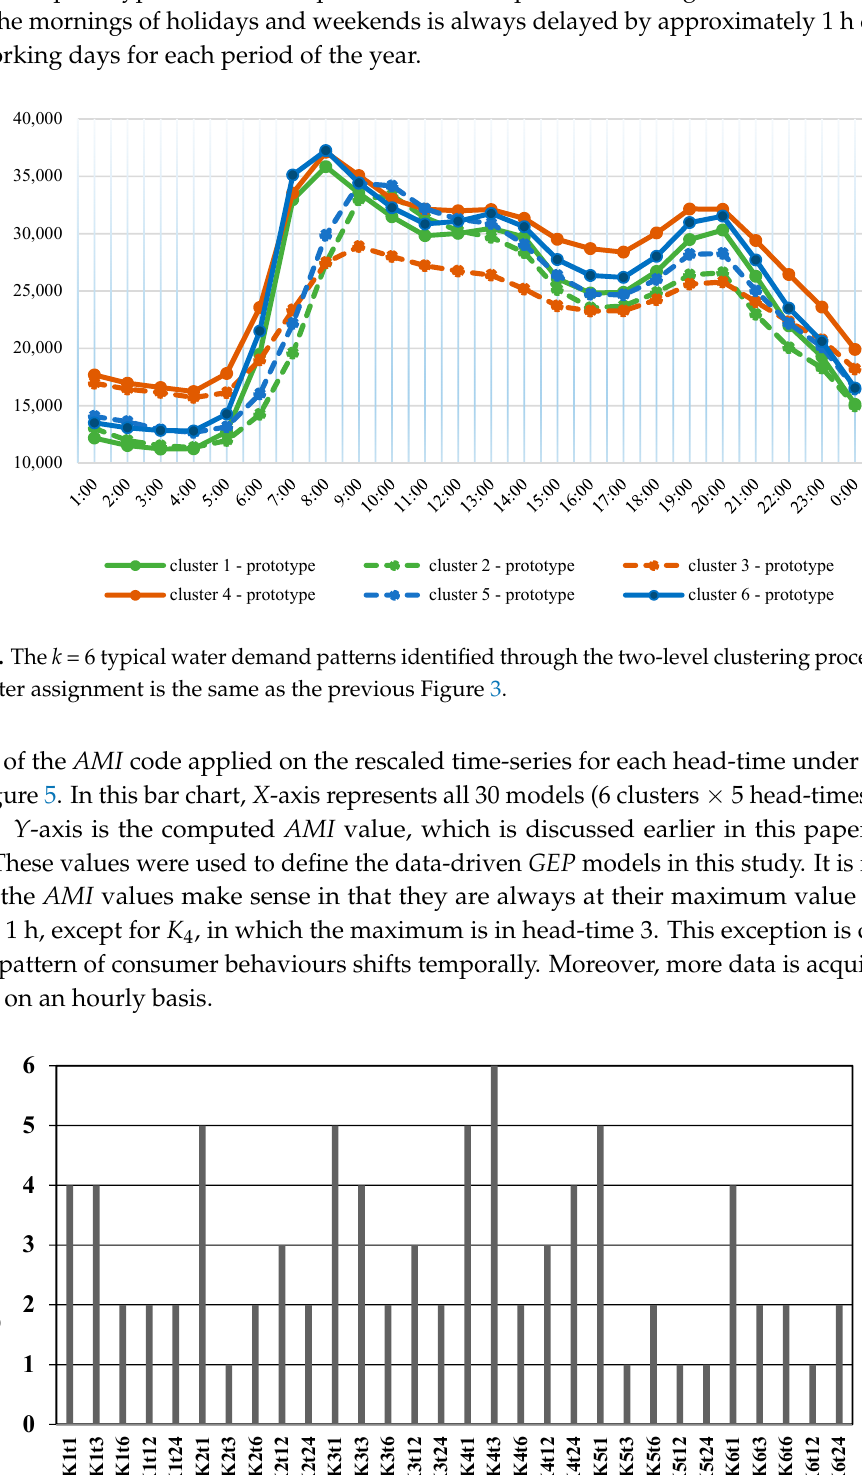
Figure 5. Average mutual information for all input designs k 1,…,6 clusters t 1,3,6,12,24 head times.